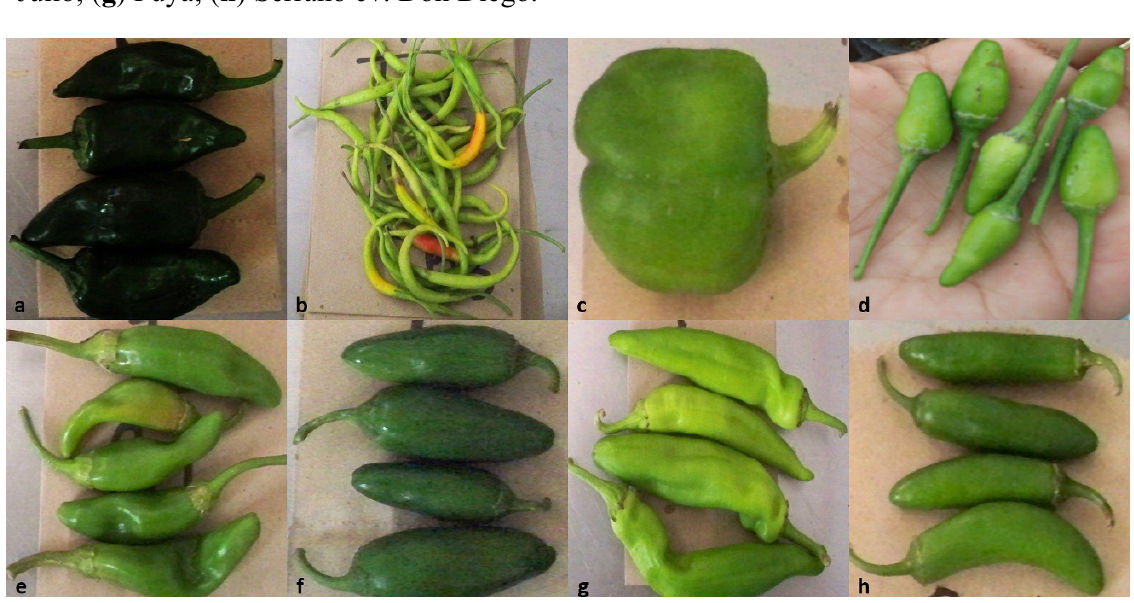
Figure 2. Chili samples used in this analysis. ( a ) Ancho cv. Don Matías; ( b ) De árbol; ( c ) Bell pepper cv. Cardinal; ( d ) Chiltepín; ( e ) Guajillo cv. San Luis; ( f ) Jalapeño cv. Don Julio; ( g ) Puya; ( h ) Serrano cv. Don